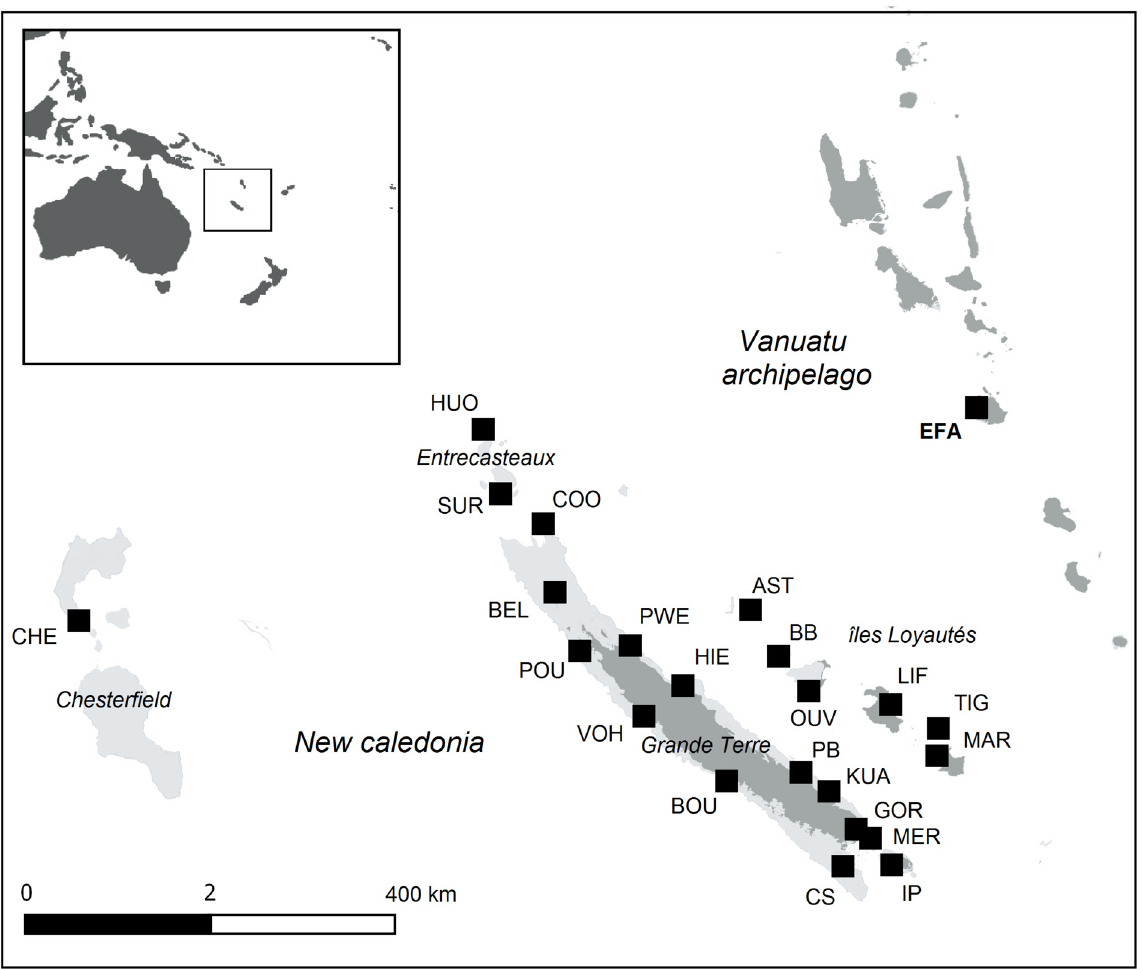
Fig 2. Location of New Caledonia and Vanuatu in the Pacific Ocean and of the 23 sites sampled for genetic analysis. The area extends from Efate (EFA, Vanuatu)in the East to the Chesterfieldislands(CHE) in the West. Location names and sampling effort per locationis available in Table 2. Land and reef maps are from the MillenniumCoral Reef MappingProject [31]. Dark grey stands for land and light grey for coral reefs.